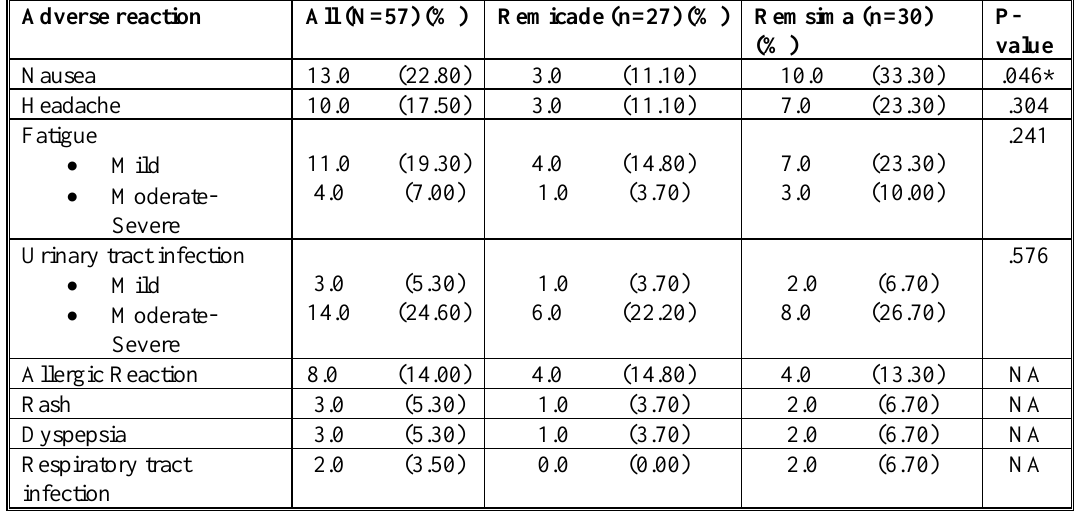
Table 2. The adverse reactions of infliximab-containing treatment regimen in the participating RA patients. Adverse reaction